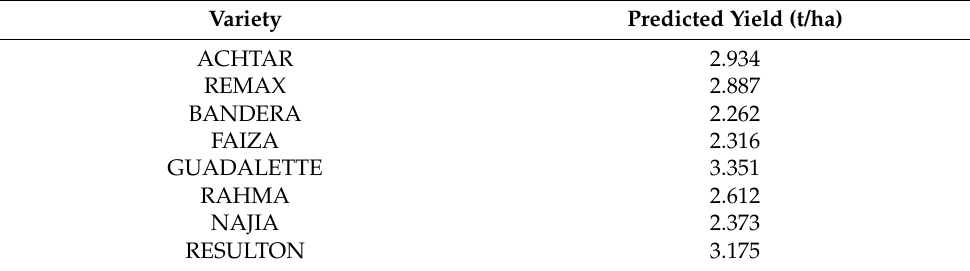
Table 8. Predicted wheat yield using varietal approach.